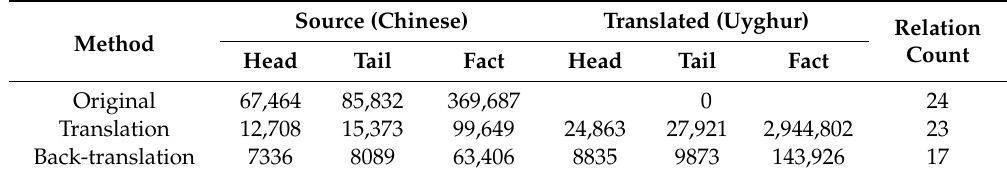
Table 2. Experimental results of dictionary-based entity